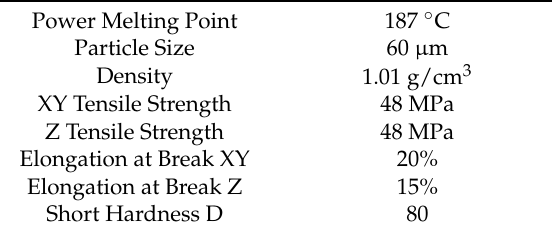
Table 5. Mechanical properties of PA